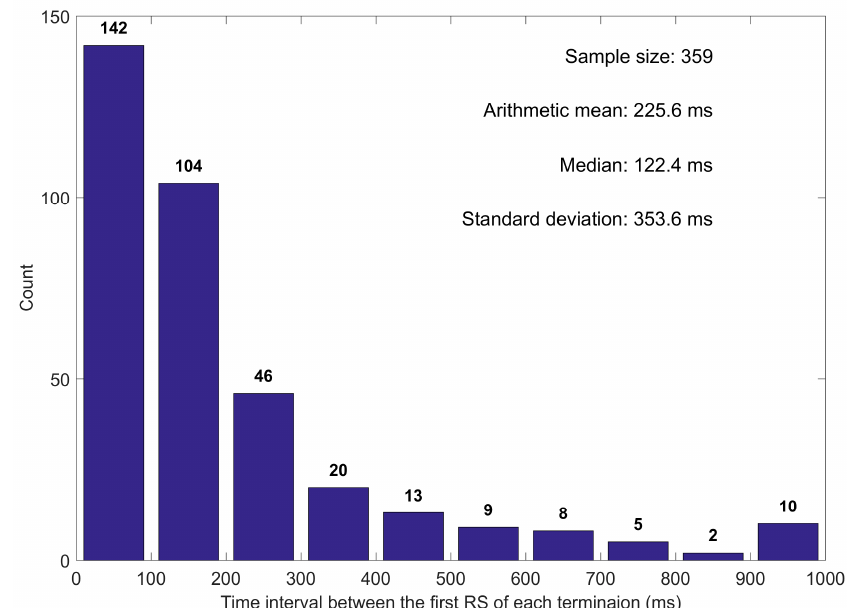
Figure 7. Histogram of the time interval between the first RS of each termination in the same MTF.